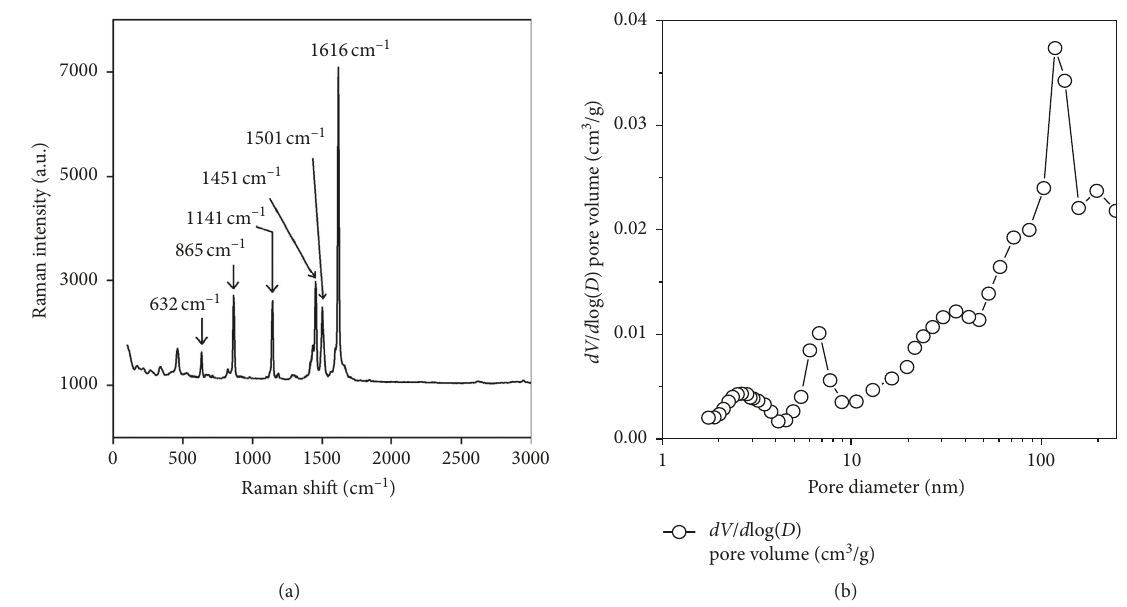
Figure 5: Raman spectrum (a) and pore size distribution (b) of